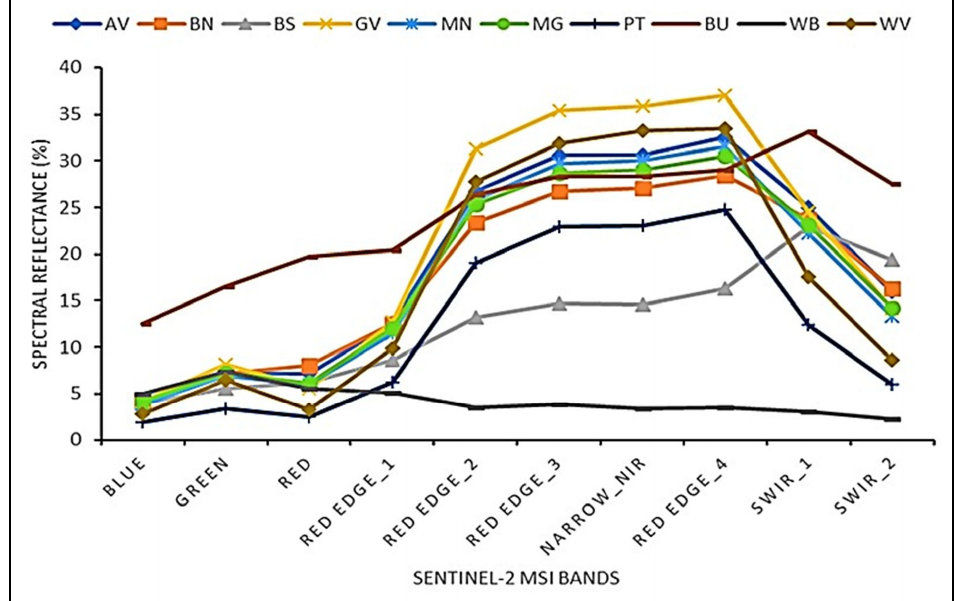
Figure 4. Spectral signature of fruit ‐ tree crops, and co ‐ existing land cover classes extracted from spectral Sentinel ‐ 2A algorithms image. The mapped classes are avocado (AV), banana (BN), bare soil (BS), guava (GV), macadamia nut (MN), mango (MG), pine tree (PT), built ‐ up (BU), water body (WB), and woody vegetation (WV).